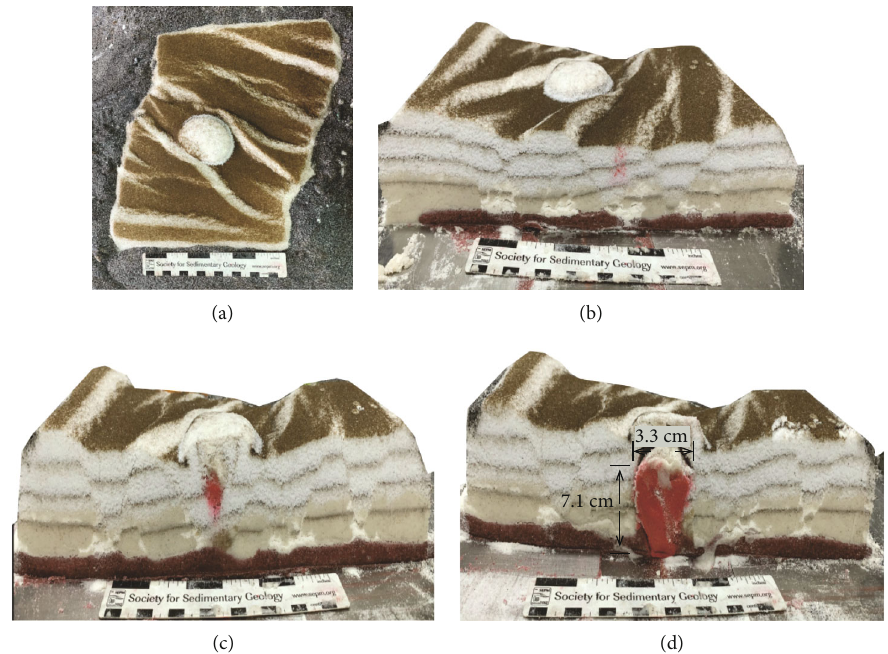
Figure 9: Formation simulation of mud diapir under 60 ° transtension. (a) Under the action of 60 ° transtension, the model appears to have distortion and deformation, resulting in symmetrical fracture; (b) side section of the model, science and technology mound-shaped uplift and a large number of fractures under the action of transtension; (c) side section of the model mound-shaped uplift edge, fl uid outlet, stratum puncture, and upward traction deformation; (d) side section of the model center, seeing the diapir upwell and punctured